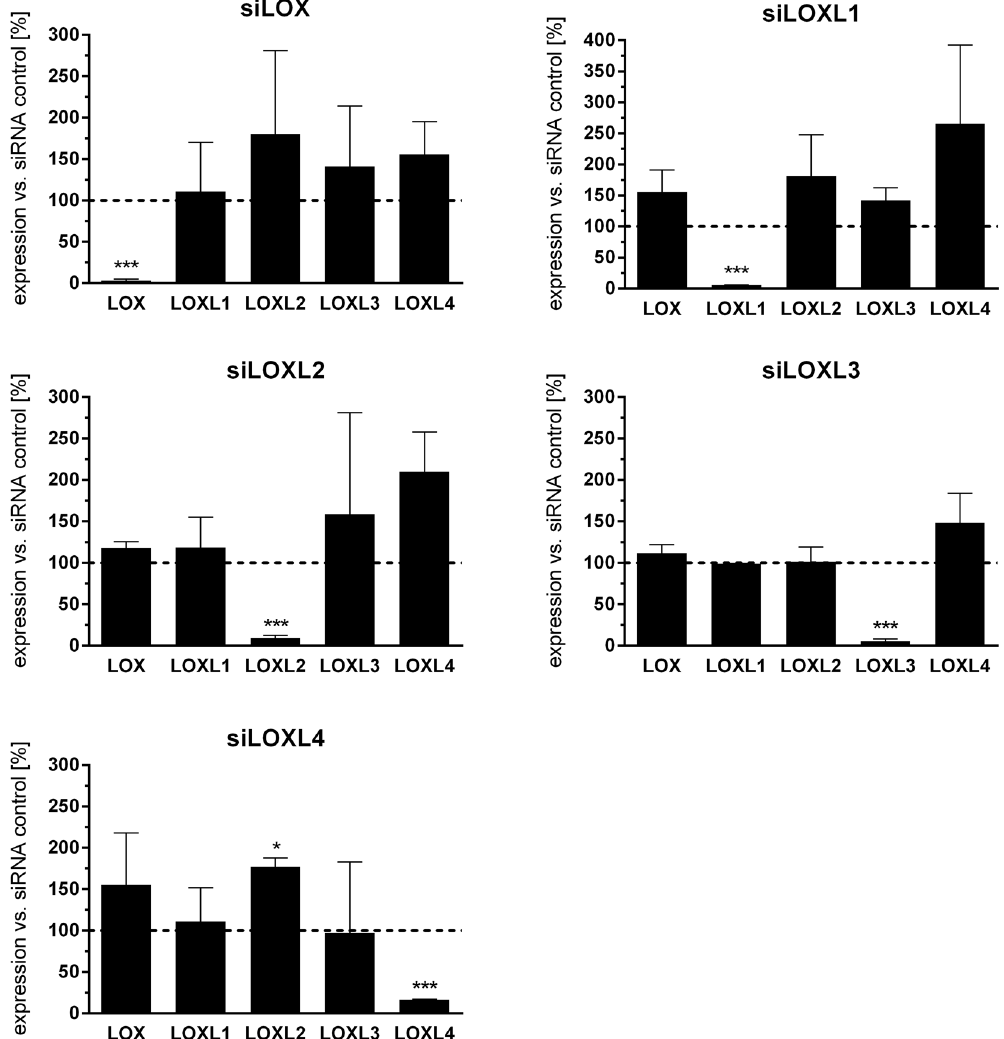
Figure 5. Knockdown efficacy and specificity of siRNA pools. Individual LOX/L siRNA pools were analyzed for their knockdown specificity following transfection of primary human lung fibroblasts (NHLFs) with 16.6 nM of control, LOX, LOXL1, LOXL2, LOXL3 or LOXL4 siRNA. 24 hours after transfection, mRNA levels of the individual LOX/L family members were determined using Taqman gene expression assays. The data is depicted as % expression compared to control siRNA treatment (which was set 100%) and presented as mean ± SD of two to four independent experiments. *** p < 0.001, relative to